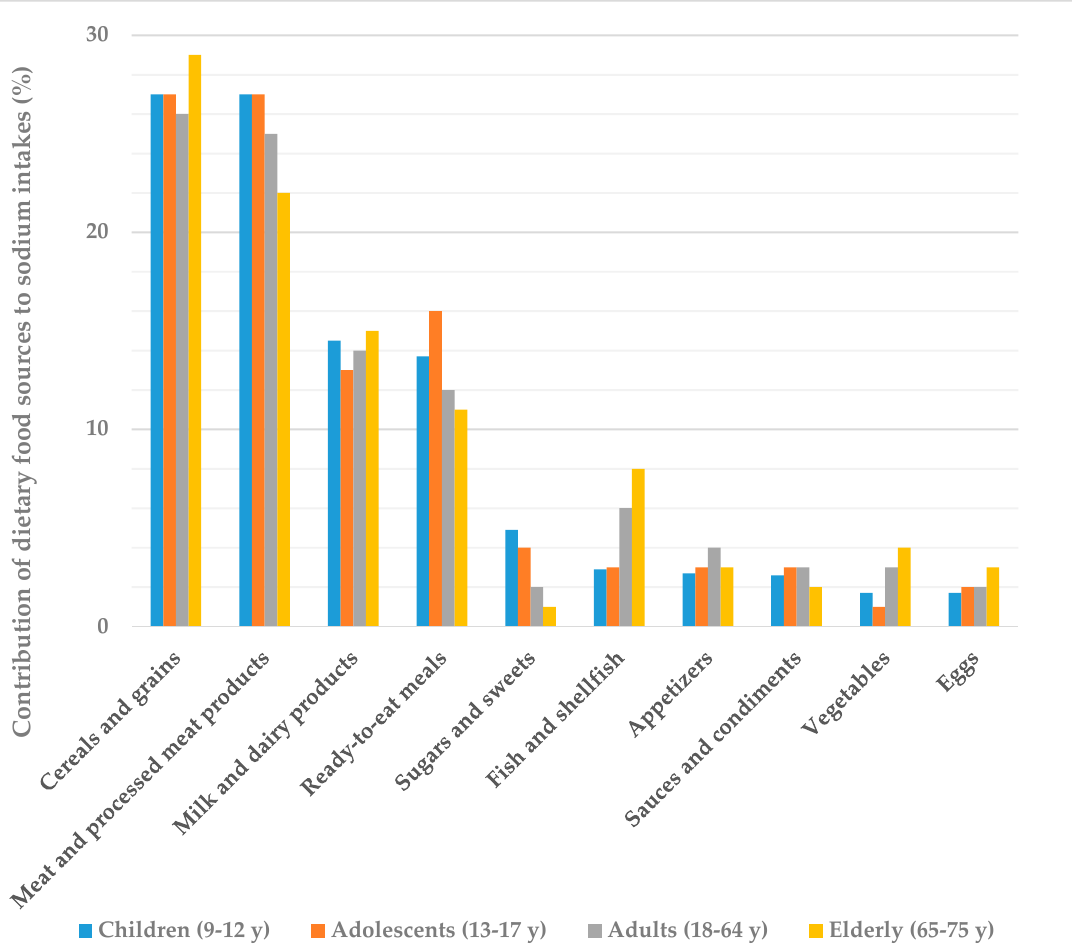
Figure 1. Dietary top ten food and beverage groups contributing to sodium intakes by different age groups from the ANIBES study population .